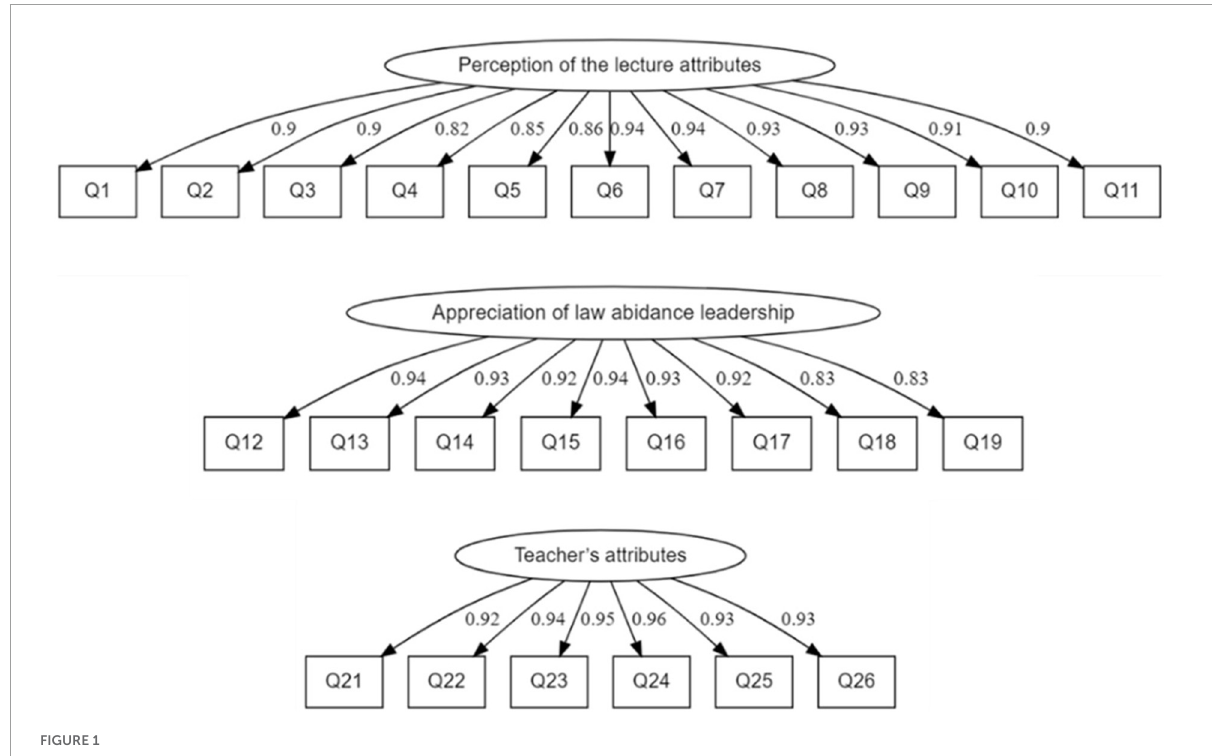
FIGURE1 The CFA